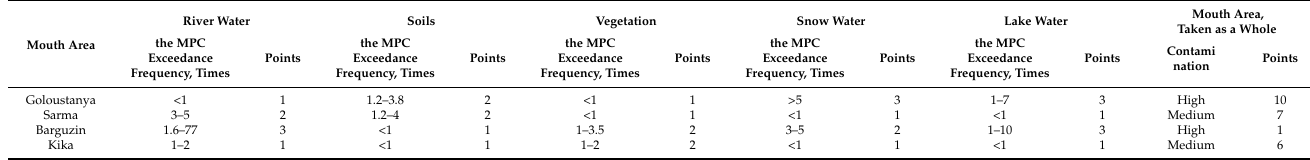
Table 2. Contamination of landscape components of mouth areas of the tributaries and coastal water area of Lake Baikal. RiverWater Soils MouthArea